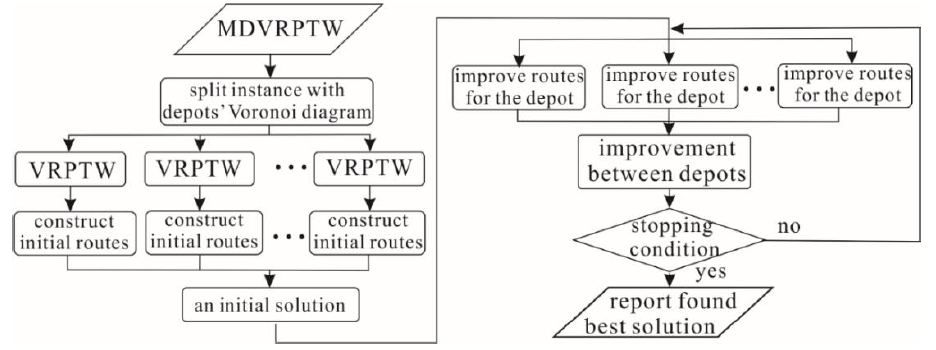
Figure 7. The adaption of the STVDH for the